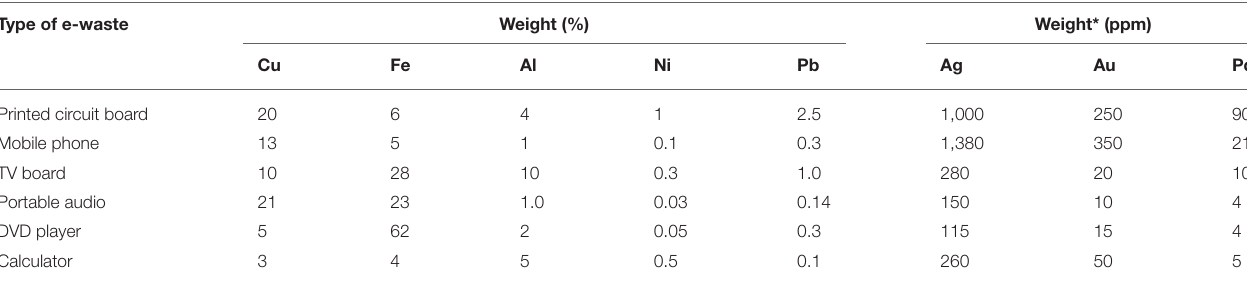
TABLE 1 | Composition of metals in various e-waste scraps. Type of